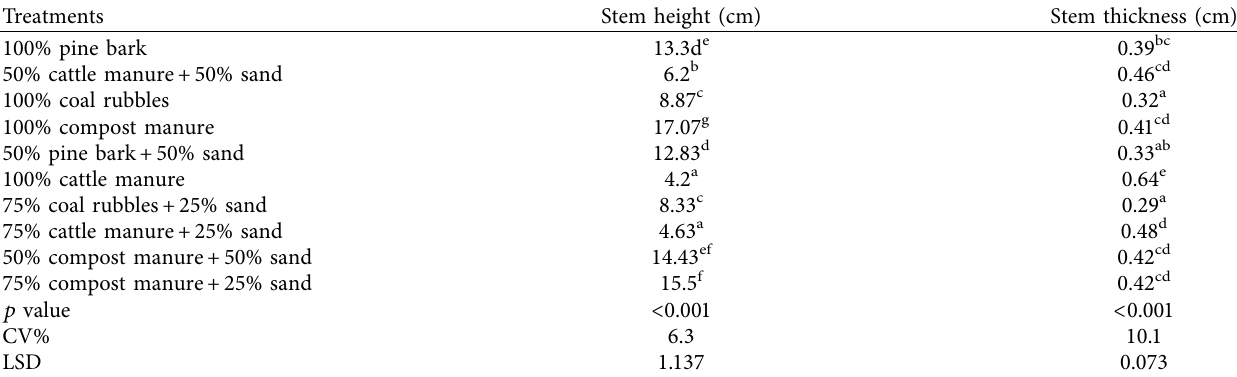
Table 3: The effect of soilless growing media on stem height and thickness of tobacco seedlings.